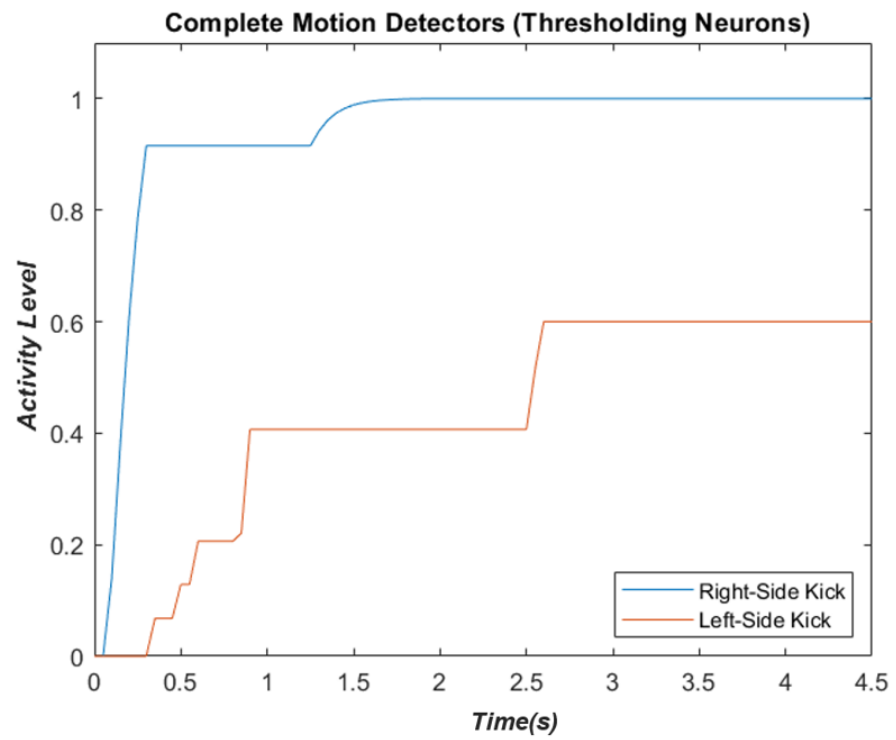
Figure 3. The neuron responsive to the right ‐ side kick (blue) is highly activated, while the inhibi ‐ tion in the other neuron is